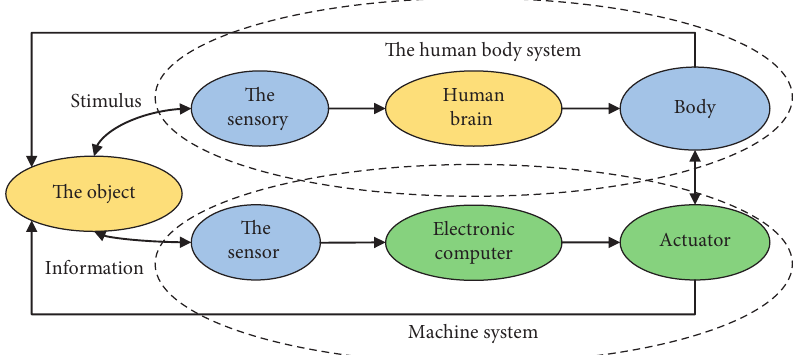
Figure 2: Schematic diagram of sensing